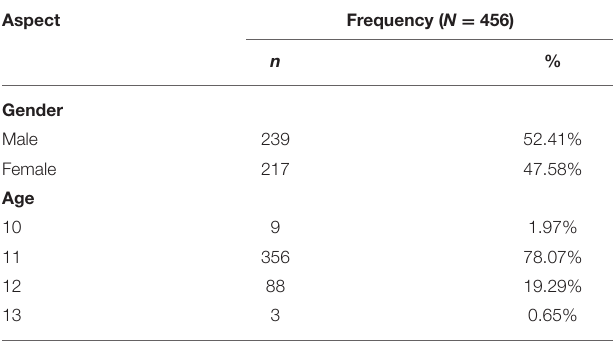
TABLE 1 | Participant